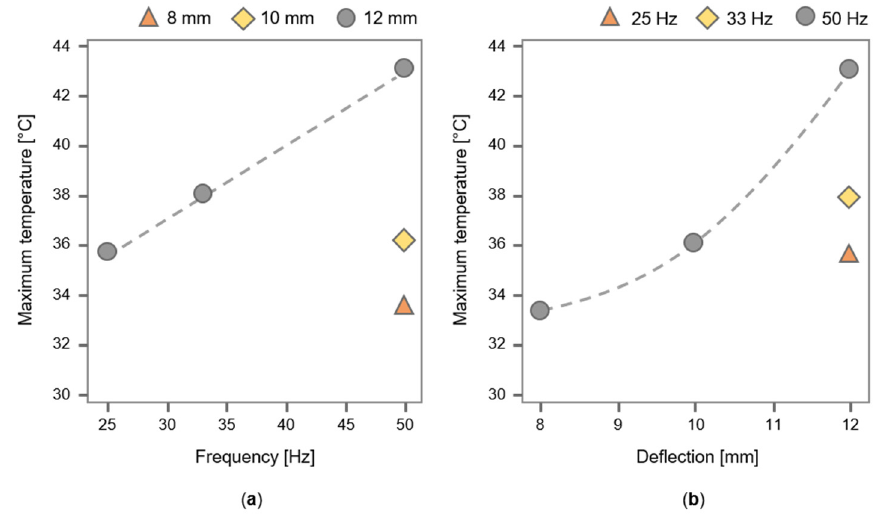
Figure 5. Initial flexural fatigue tests to investigate the influence of ( a ) frequency on the maximum temperature for different deflections and ( b ) deflection on the maximum temperature for different frequencies.